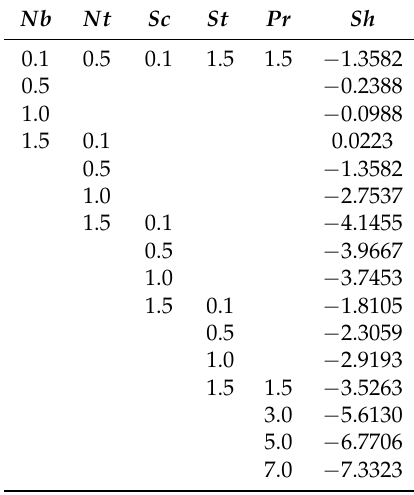
Table 4. For dissimilar values of Nb , Nt , Sc , Pr , and St , variations in Sherwood Number.